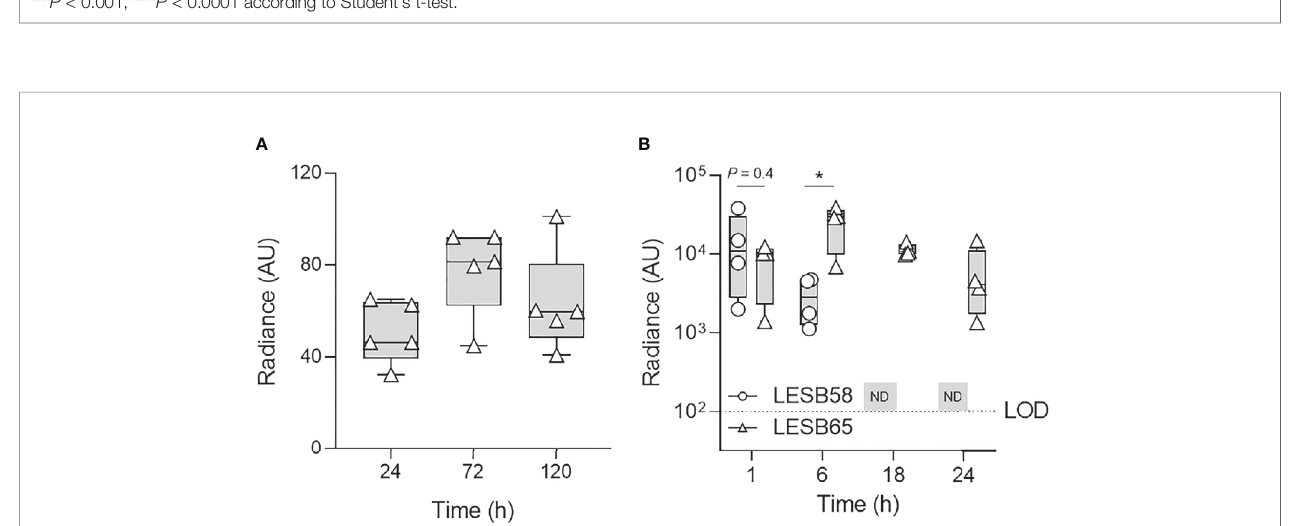
FIGURE 5 | P. aeruginosa LESB65 persisted in the nasal cavity for up to 5 days and elicited a prolonged in fl ammatory response. P. aeruginosa LESB65-Lux encapsulated in sodium alginate (11 mg/ml) was inoculated dropwise in the left naris of C57Bl/6 mice (~10 6 CFU). (A) Bacteria were detected by luminescence imaging for up to 120 h. (B) Localization of oxidative species to the site of LESB58 or LESB65 infection was tracked using the chemiluminescent L-012 sodium salt probe (25 mg/kg). No difference in the mean intensity of the signal was detected until 6 h post-infection, at which time the signal was stronger in mice treated with LESB65. The signal was not detected (ND) in mice treated with LESB58 beyond this time point. n = 4-5. Data are shown as geometric mean ± SD. The limit of detection (LOD) is shown as a dotted line at 10 2 counts. * P < 0.05 according to Student ’ s t-test.